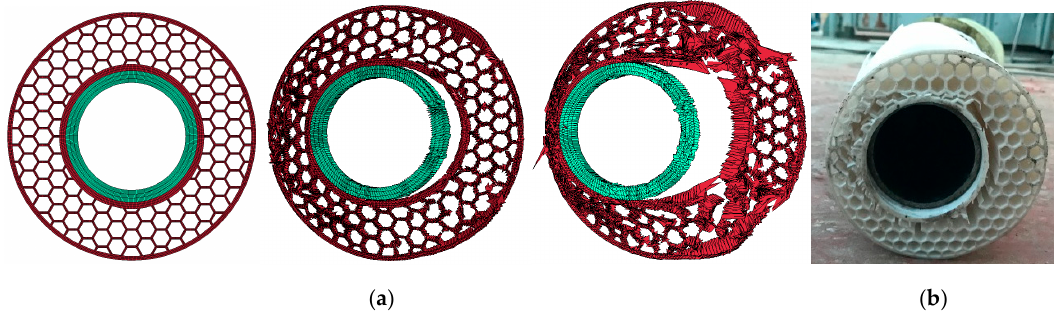
Figure 22. Comparison of bottom honeycomb unit and damaged honeycomb simulation: ( a ) Simulation results; ( b ) Collision test results.